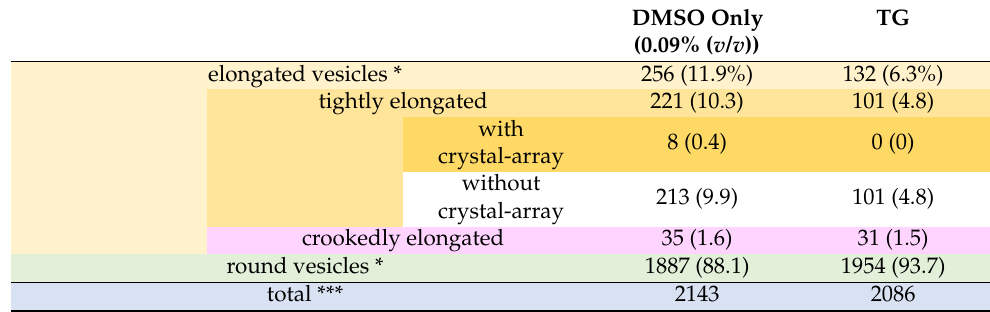
Table 3. Number of elongated and round-type vesicles in SR samples with and without thapsigargin (TG), observed at 0.04 nM Ca 2+ in the presence of ATP. The SR vesicles (0.3 mg protein/mL) were incubated overnight with and without TG (1.5 µ M in DMSO), having 23 mM ATP and 0.04 nM Ca 2+ at pH 7.4 and 0 ◦ C. The vesicles observed within the electro-microscopic view of 4.5 µ m by 4.5 µ m were classified as elongated or round types, as described in Table 1. To assess vesicle morphology in the absence of TG, 8 images were recorded from regions that included one or more elongated vesicle with a crystal-array of surface particles (see Figure 10a,b), and the 75–311 vesicles per 4.5 µ m by 4.5 µ m image were classified. To assess vesicle morphology in the presence of TG, 11 images were recorded from regions that included one or more tightly elongated vesicle(s) without a crystal-array of surface particles (see Figure 10c,d), and the 169–328 vesicles per 4.5 µ m by 4.5 µ m image were classified. No vesicles with a crystal-array were detected. The data are summarized in the table (see text for details). The number of each type of vesicle relative to the total number of vesicles (elongated and round), at the respective calcium concentration is given as a percentage in parenthesis for both data sets. Yellow, pink and green represent elongated, crookedly elongated and round vesicles, respectively. Cream-, straw- and saffron-yellow represent elongated vesicles, tightly elongated vesicles, and tightly elongated vesicles with a crystal-array, respectively.